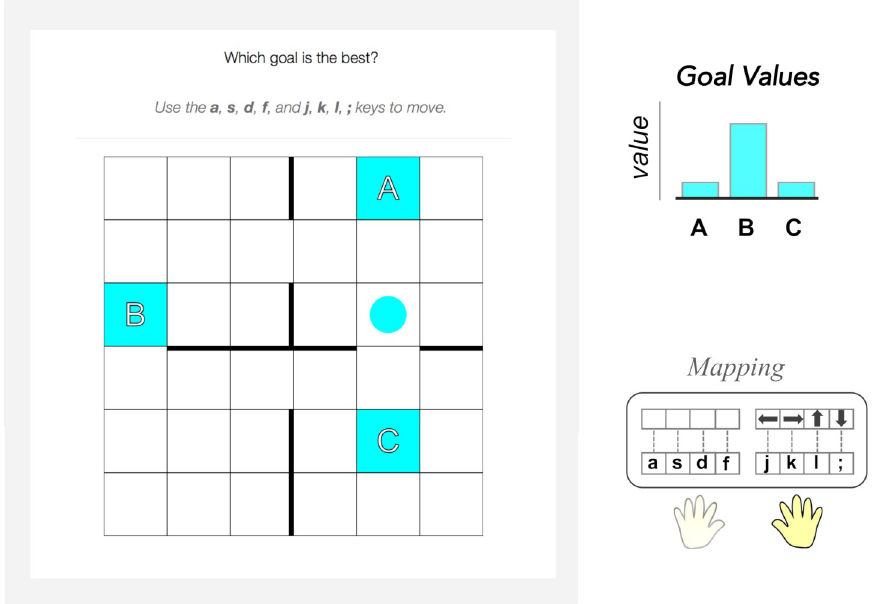
Fig 1. Subjects controlled a circle agent in a grid world (left) and navigated to one of three potential goals (colored squares labeled “A”, “B”, or “C”). Context was signaled to the subject with a shared color for the agent and goals. In each context, subjects learned the identity of the rewarded goal within the trial (top right) while also learning a mapping between the keyboard responses and the cardinal movement within the grid world (bottom right).